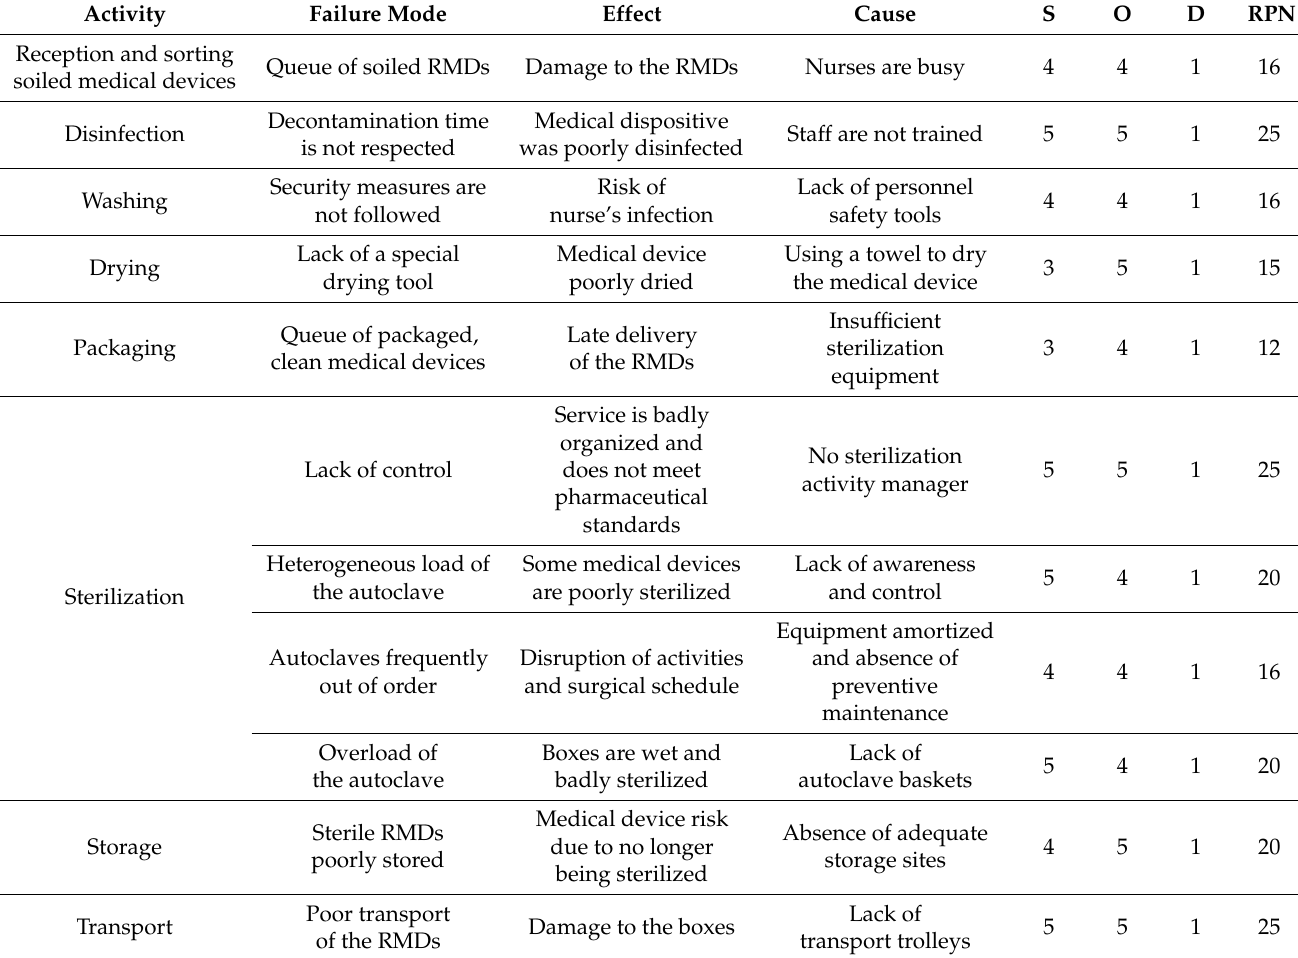
Table 3. FMEA table of the hospital sterilization process.